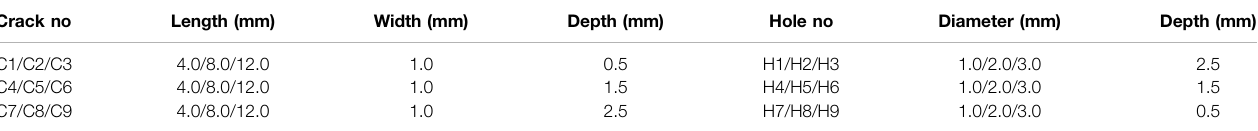
TABLE 2 | Parameters of defects.